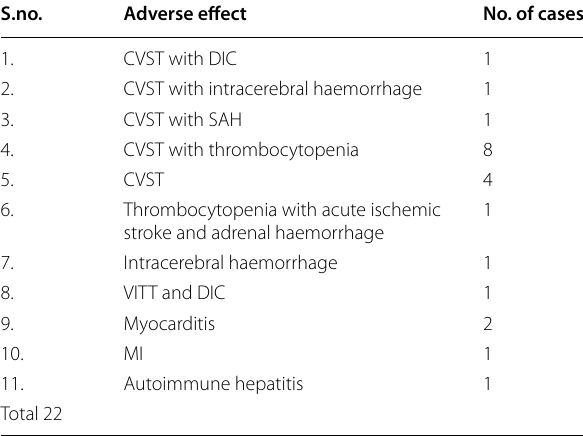
CVST Cerebral venous sinus thrombosis, DIC Disseminated intravascular coagulation, SAH Subarachnoid haemorrhage, VITT Vaccine-induced thrombotic thrombocytopenia, MI Myocardial infarction